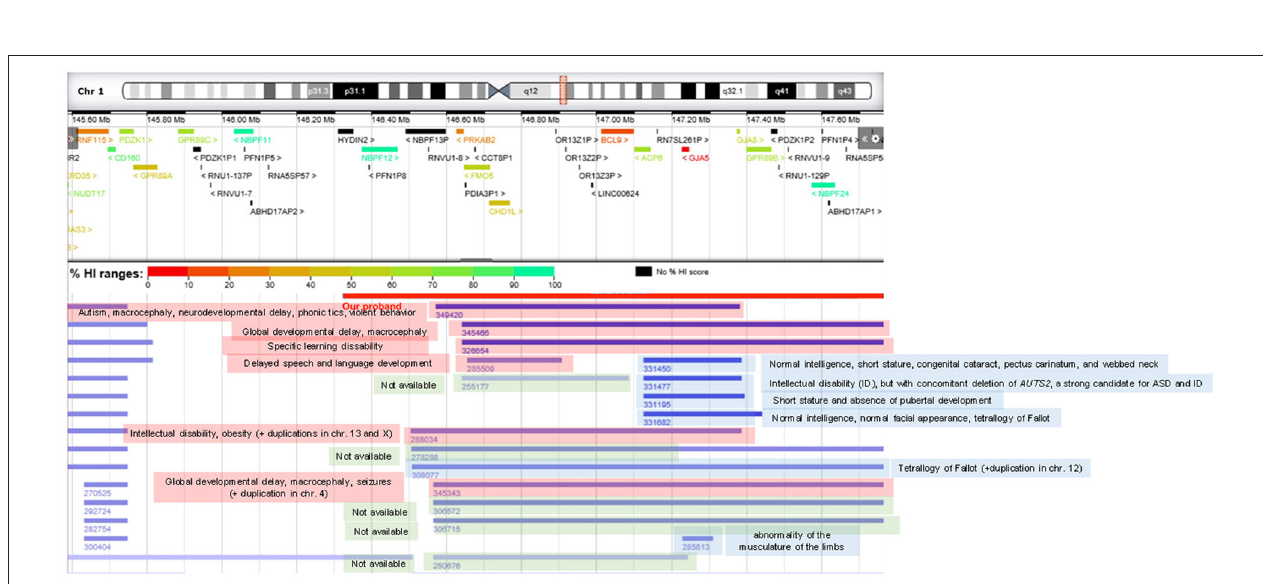
FIGURE 4 | DECIPHER patients of interest bearing chromosomal duplications at 1q21.1 with similar or smaller sizes than the one found in the proband. Patients with cognitive deficits are highlighted in red, cases with no cognitive problems are highlighted in blue, whereas patients for whom no phenotypic profile is available are highlighted in